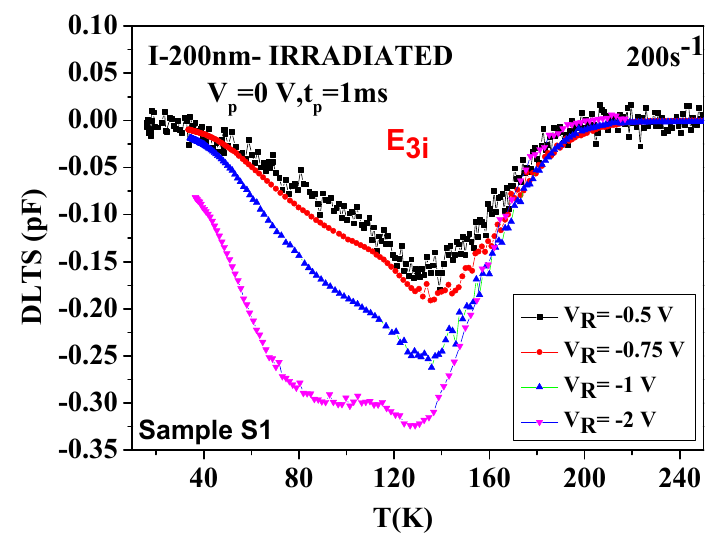
Figure 7. A typical capacitance DLTS spectrum recorded for irradiated sample S1 with